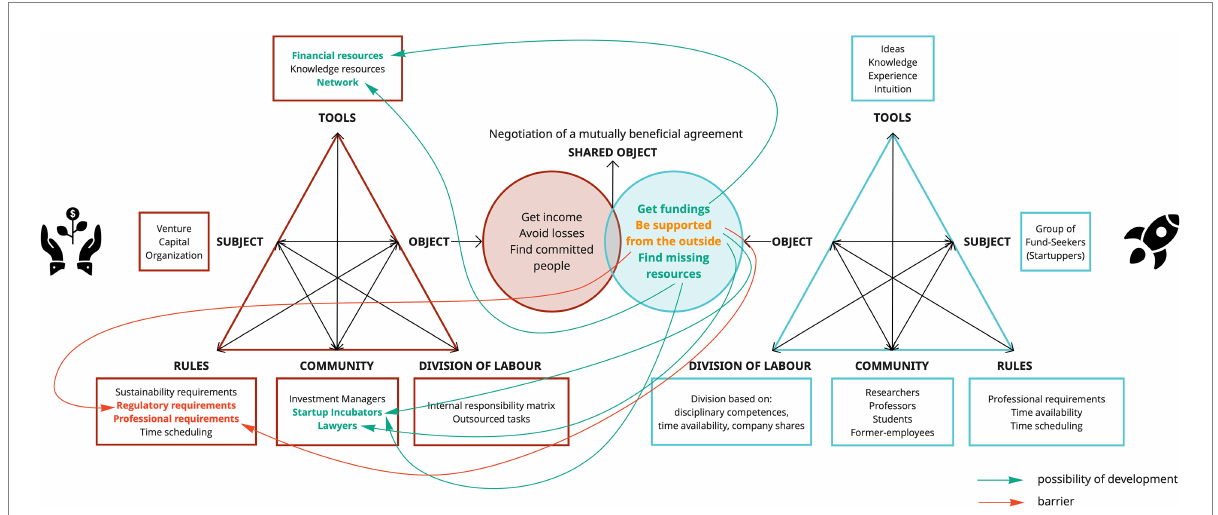
FIGURE 9 Examples of bridging points between activity systems in the field of startup